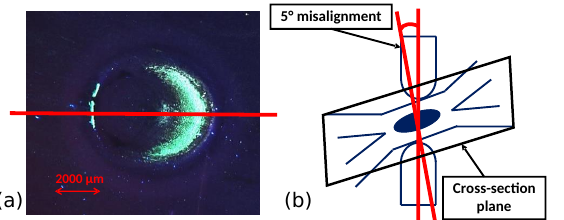
Figure 4. Dye penetrant inspection ( a ) and the plane of observation for metallographic analysis ( b